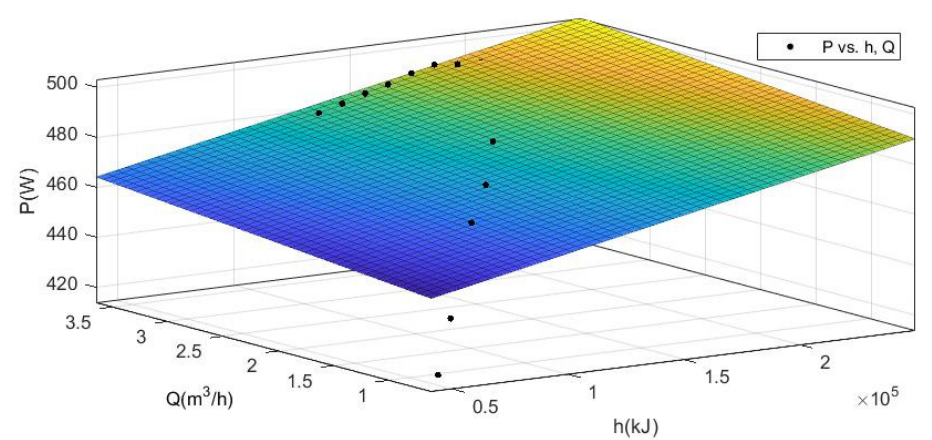
Figure 10. Variation of the optimal flow rate and pump power as the cooling capacity changes. It should be noted that there is a limit to the cooling capacity h that the system can supply for a period of time due to the upper limit of pump power. When applying the algorithm, be careful not to set the h value of cooling capacity beyond the limit, otherwise there will be operational